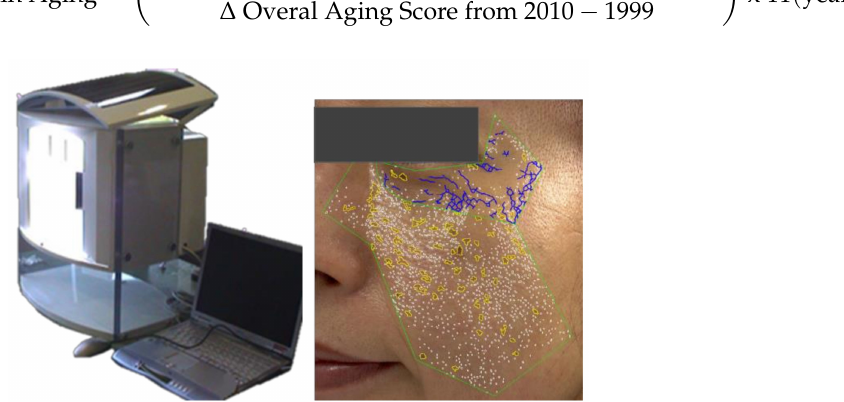
Figure 1. Beauty Imaging System (BIS) and image analysis overlays of wrinkles, spots, roughness, and